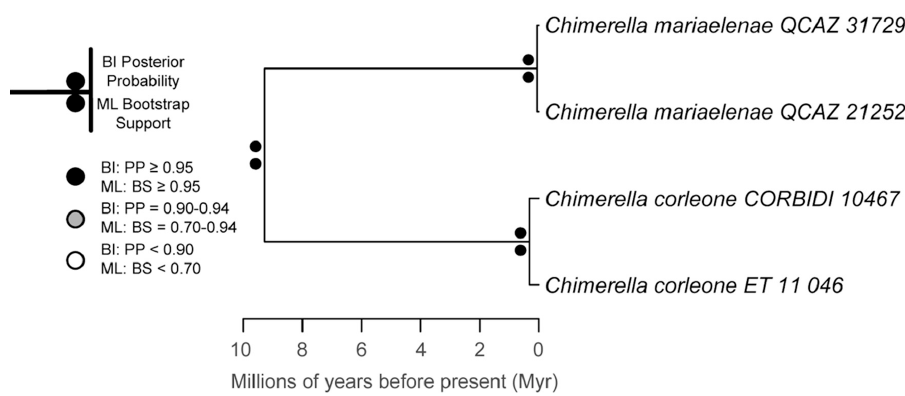
Figure 66. Evolutionary relationships between species in the genus Chimerella , inferred using maximum likelihood and Bayesian criteria.